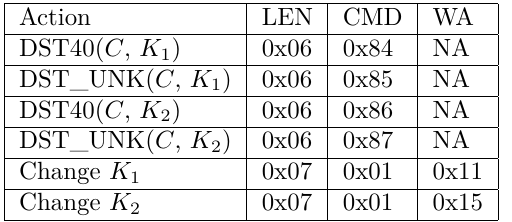
Table 1: An overview of the publicly undocumented commands of interest which we discovered. We denote the challenge and keys, respectively, as C and K .